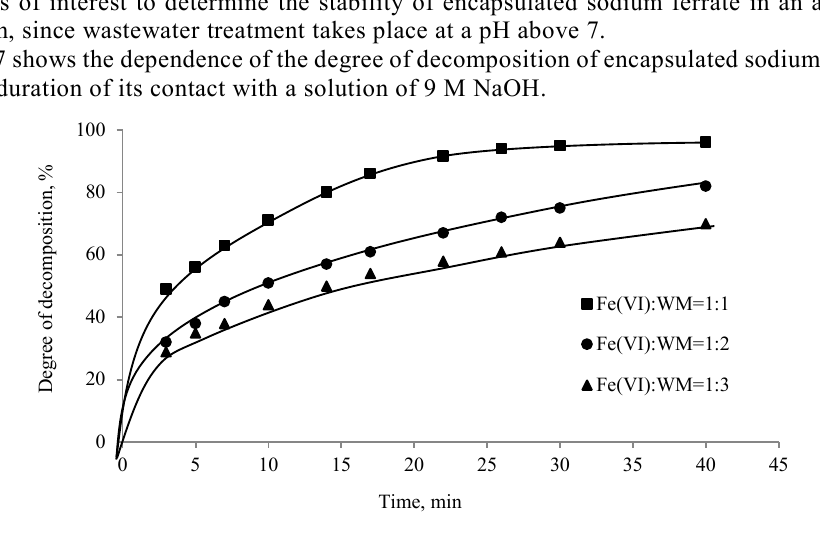
Fig. 7. Dependence of the degree of decomposition of encapsulated sodium ferrate on the duration of its contact with a solution of 9 M NaOH. The maximum degree of decomposition of the encapsulated sodium ferrate reaches 90 % in 30 minutes of contact of the capsules with the